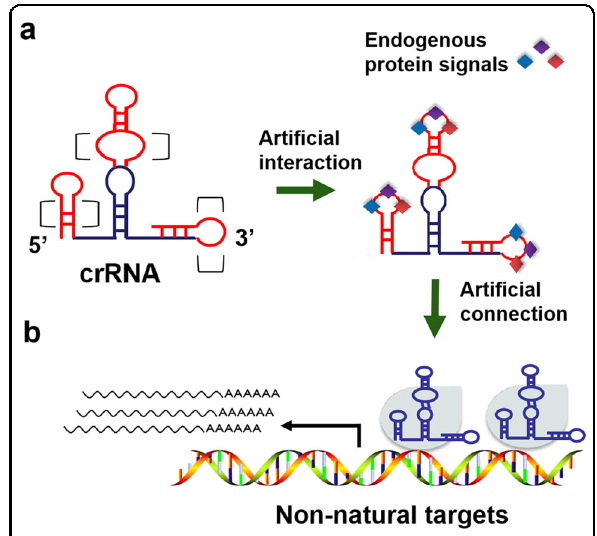
Fig. 1 Design and construction of CRISPR signal conductor 2.0. a The possible insertion sites for lncRNA functional motifs in the crRNA of CRISPR-dCas Φ . The 5 ′ -end, 3 ′ -end, and intermediate stem-loop of crRNA were sequentially inserted with protein-binding RNA elements and a lncRNA functional motif-based riboswitch. b CRISPR signal conductor 2.0 bound different endogenous proteins, including transcriptional activators, transcriptional repressors, and RNA-binding proteins, through reprogrammed crRNA, and then regulated the expression of target genes in cells, forming a logical network controlled by multiple